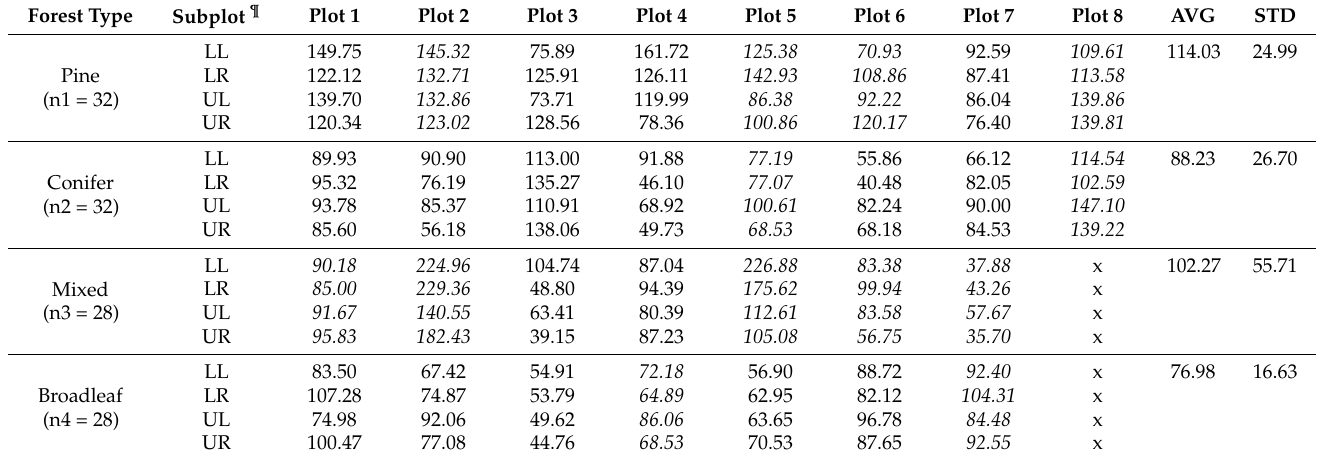
¶ : The same as in Table 2. The italics is used to highigh the partiular plots. The inclusion of FDW mass did not change the relationship of the total surface fuel loads among the forest types, that is, the pine stand had the highest amount of tSFL, followed by the mixed, conifer, and broadleaf stands. The significant variation in tSFL in the mixed stands remained significantly larger than that in the other forest types. The R-squared value of the derived lntSFL-BioTopo model as shown in Equation (6) was 0.144 (F = 2.701, p < 0.013, n = 120). The performance of this model in predicting tSFL of the whole forest had an RMSE of 35.02 kg/pixel, corresponding to a PRMSE of 36.57%. Similarly, Equation (7) shows the alternative lntSFL-BioTopo model for tSFL estimation using NFT, 4-classes SC, 4-classes AC, and their interaction product variables. The R-squared value of this model was 0.168 (F = 7.836, p < 0.001, n = 120), and RMSE and PRMSE were 33.81 kg/pixel and 37.85%, respectively. The performance measures of the two models were also quite close, with a difference in RMSE and PRMSE of 1.21 kg/pixel and 1.28%, respectively. In contrast to Equation (6), the relative change in the two measures of Equation (7) was 3% and